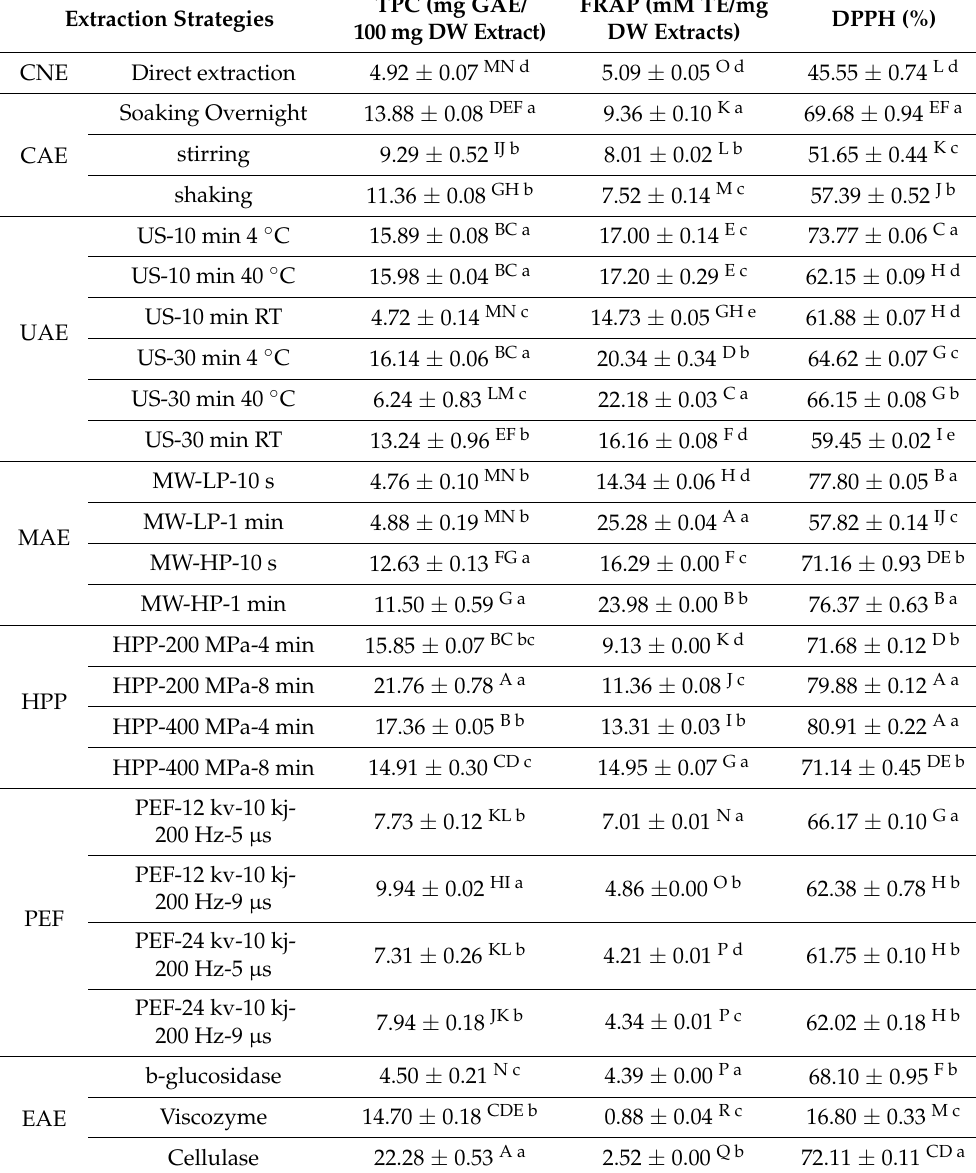
Table 1. Total phenolic content (TPC) and antioxidant (FRAP and DPPD) activity of buck- wheat hull extracts obtained from different extraction strategies (i.e., control (CNE), conventional- assisted extraction (CAE), ultrasound-assisted extraction (UAE), microwave-assisted extraction (MAE), high-pressure processing (HPP), pulsed electric fields (PEF), and enzyme-assisted extraction (EAE)